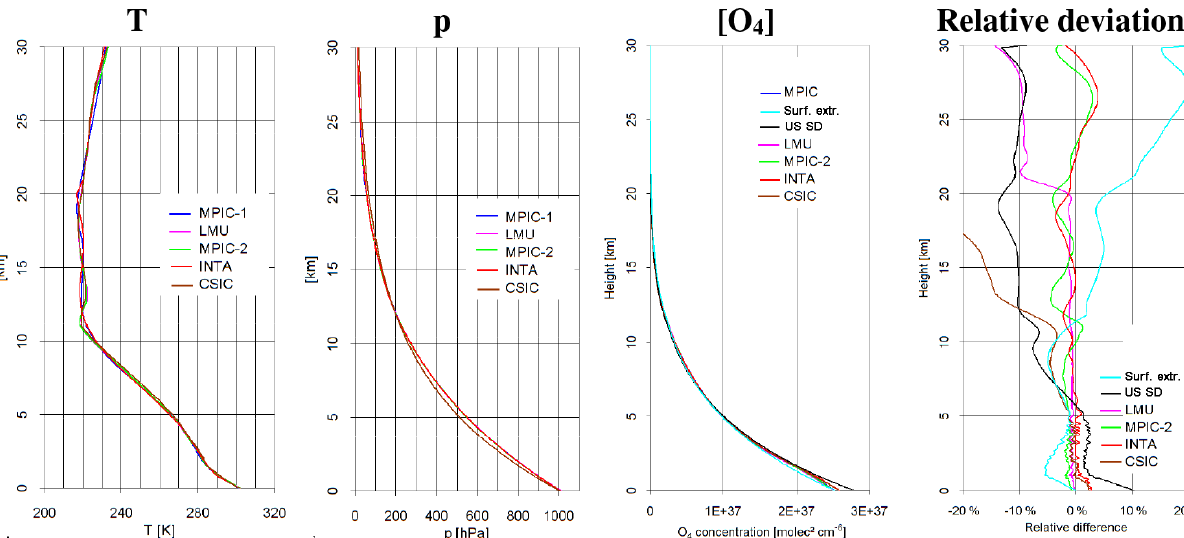
Figure 6. Comparison of the vertical profiles of temperature, pressure and O 4 concentration (expressed as the square of the O 2 concentration) for 8 July, 11:00–19:00, extracted by the different groups. In the right panel the relative deviations in the O 4 concentration are shown compared to the MPIC standard extraction. There, the profiles derived from the extrapolation from the surface values and the US standard atmosphere are also included.